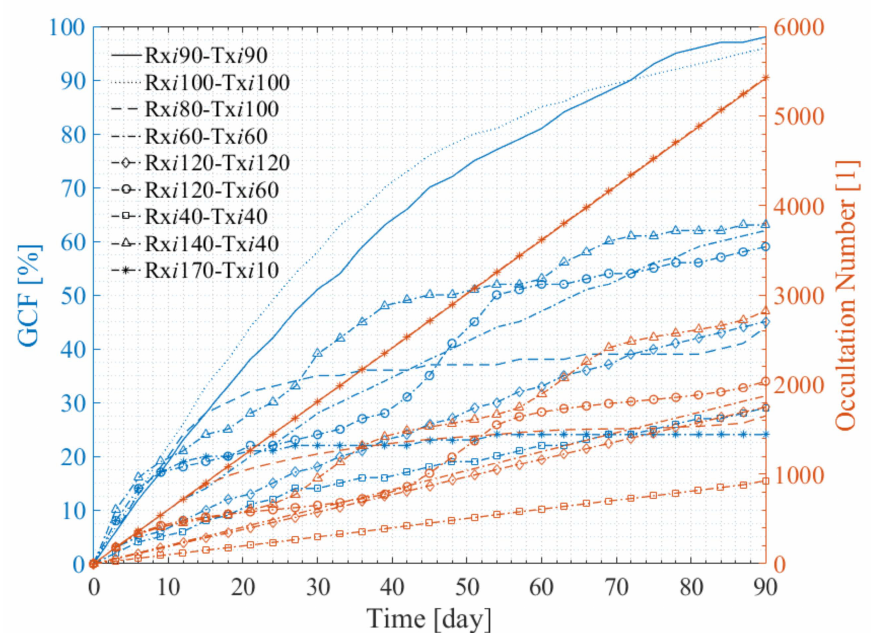
Figure 4. The accumulated time dependence of the LEO-LEO occultation event number (orange lines) and the global coverage fraction (GCF) (blue lines) for the representative LEO-LEO constellations composed of a Rx satellite and a Tx satellite with particular orbital